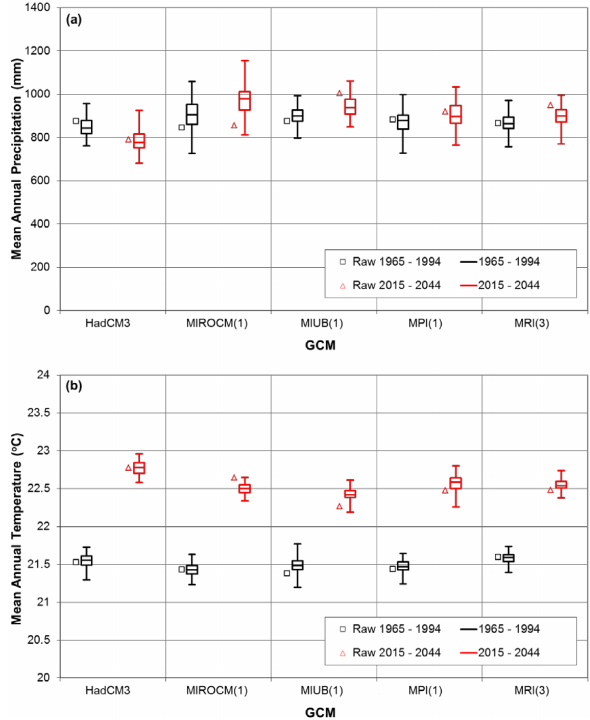
Figure 5. Box plots of 30-year mean annual (a) precipitation and (b) temperature for the periods 1965–1994 (20C3M) and 2015– 2044 (A1B) for five GCMs. Each box plot is based on 100 quantile– quantile bias-corrected stochastic replicates of GCM data for catch- ment 6058 – Herbert River at Gleneagle (Australia). The box rep- resents the inter-quartile range and the whiskers extend to the max- imum and minimum values. The Raw value next to each box plot represents the bias-corrected mean annual value from the GCM run that the stochastic replicates are based